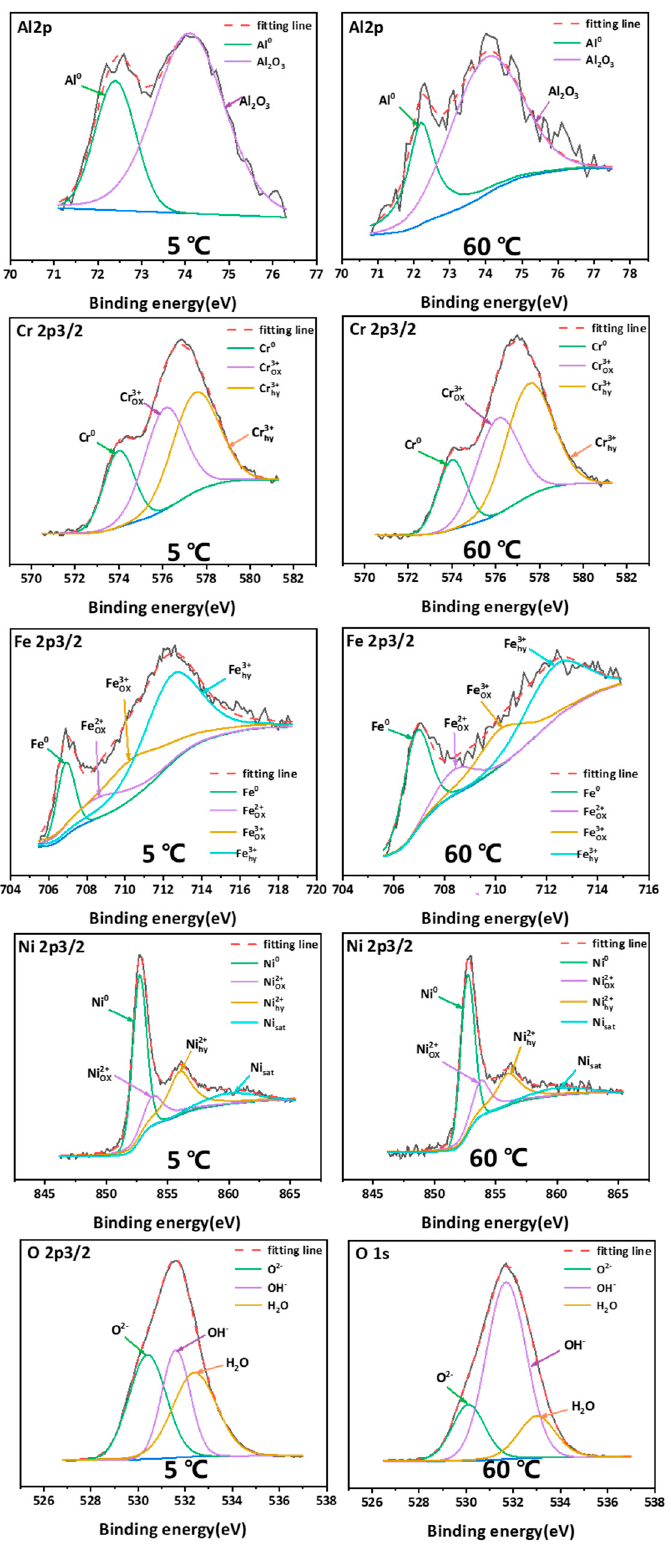
Figure 10. XPS results for Al 2p, Fe 2p3/2, Cr 2p3/2, Ni 2p3/2, and O 1s in the film on AlCoCrFeNi 2.1 in chloride-containing sulfuric acid solutions at 5 ℃ and 60 ℃ .